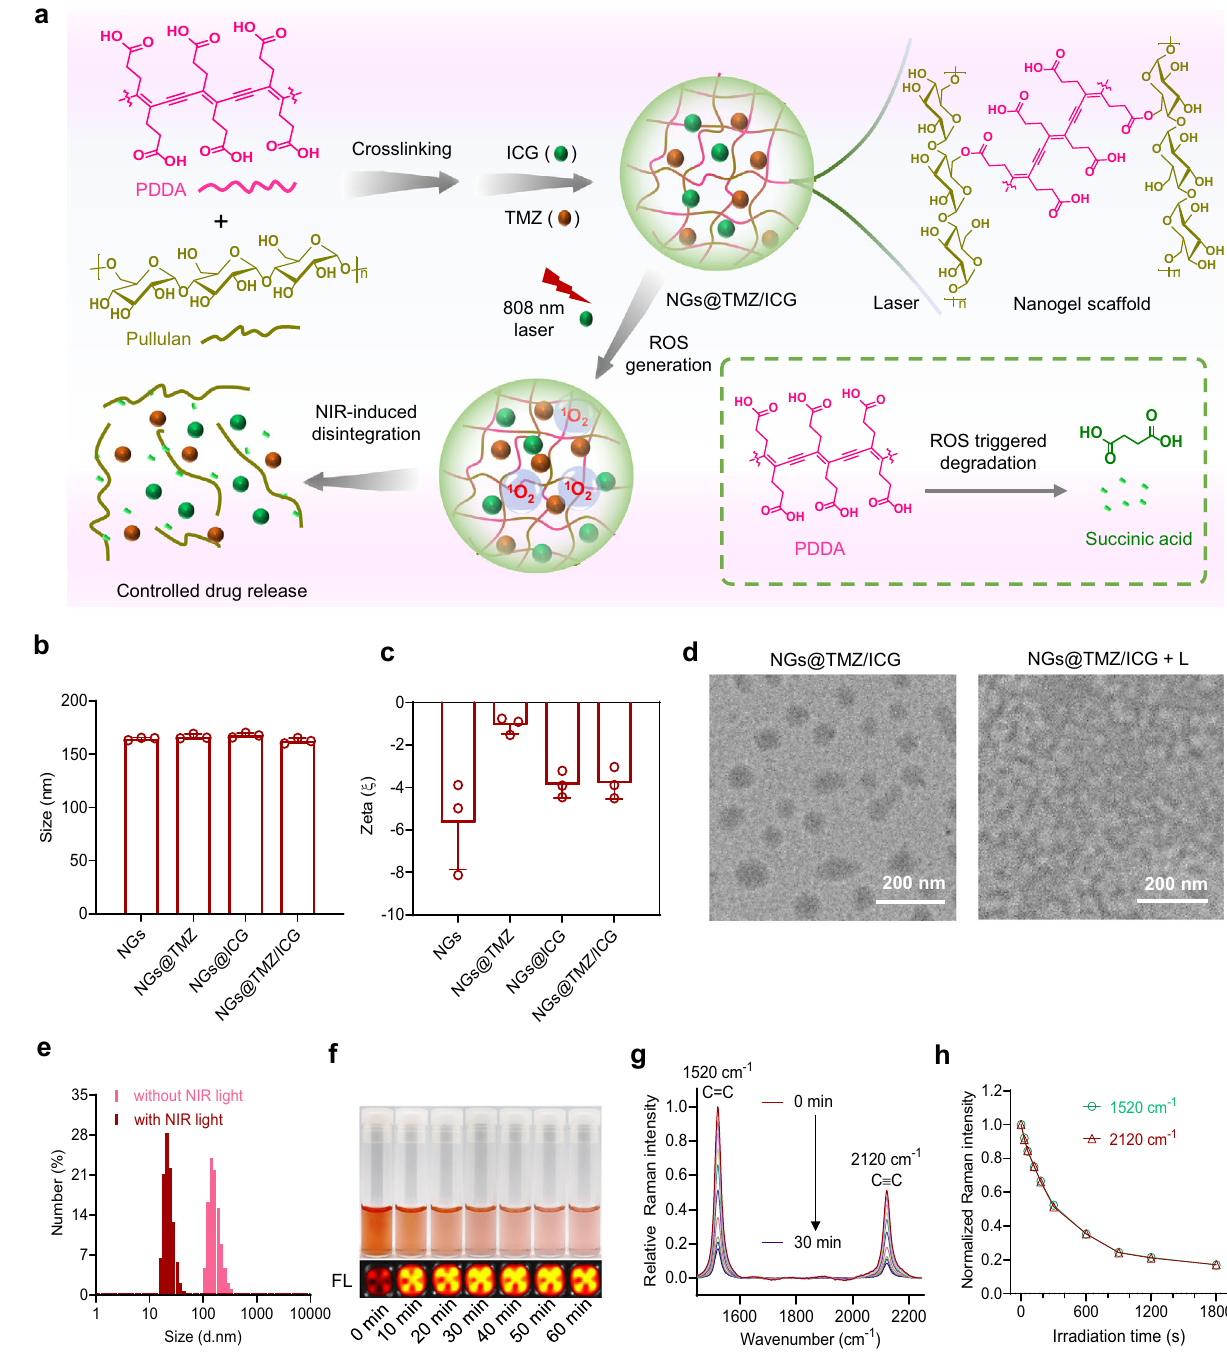
Fig. 2 | Preparation and NIR-induced disintegration of NGs@TMZ/ICG. a Schematic illustration of the synthesis of the nanogels and their NIR-induced disintegration. b , c Sizedistribution( b )andzetapotential( c )ofthecorresponding nanoparticles measured by DLS (n=3 independent experiments). Data are pre- sented as mean±SD. d TEM images of the NGs@TMZ/ICG before and after NIR irradiation (808nm, 0.5Wcm − 2 , 5min). e Particle sizes of NGs@TMZ/ICG before